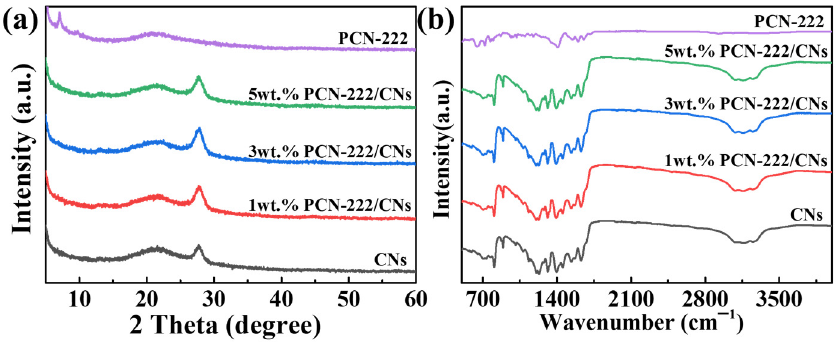
Figure 1. ( a ) XRD patterns and ( b ) FT-IR patterns of PCN-222, CNs and PCN-222/CNs.